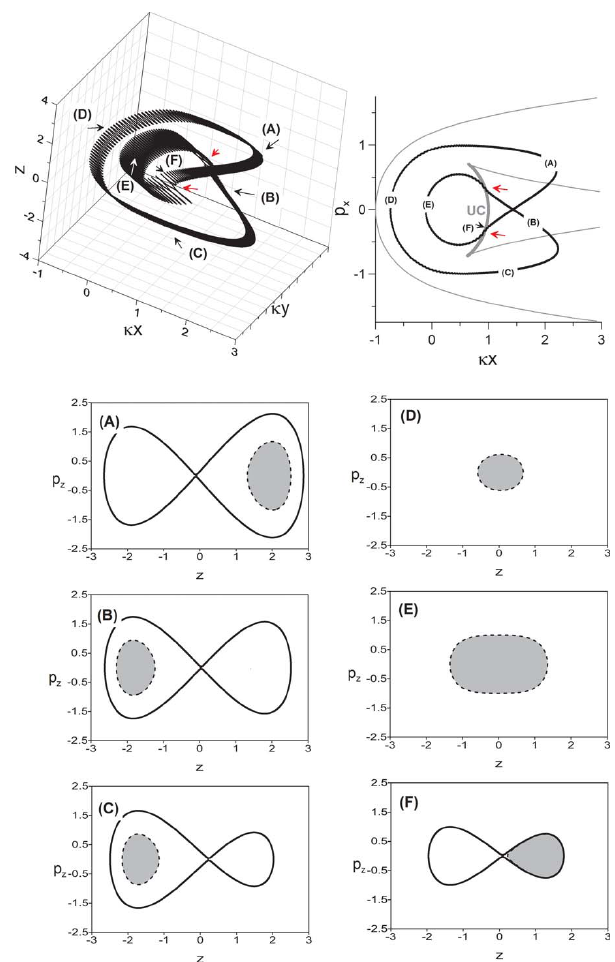
Fig. 1. The particle trajectory in 3-D space and its projection onto the plane (κx,p x ) are shown in top panels. Red arrows show po- sitions of the uncertainty curve (UC) crossings. The corresponding fragments of the particle trajectory in the plane (z,p z ) are presented in the bottom panels. The solid curve is the separatrix, while the dashed curve is the trajectory. Grey colour indicates the area, which is equal to 2 πI z